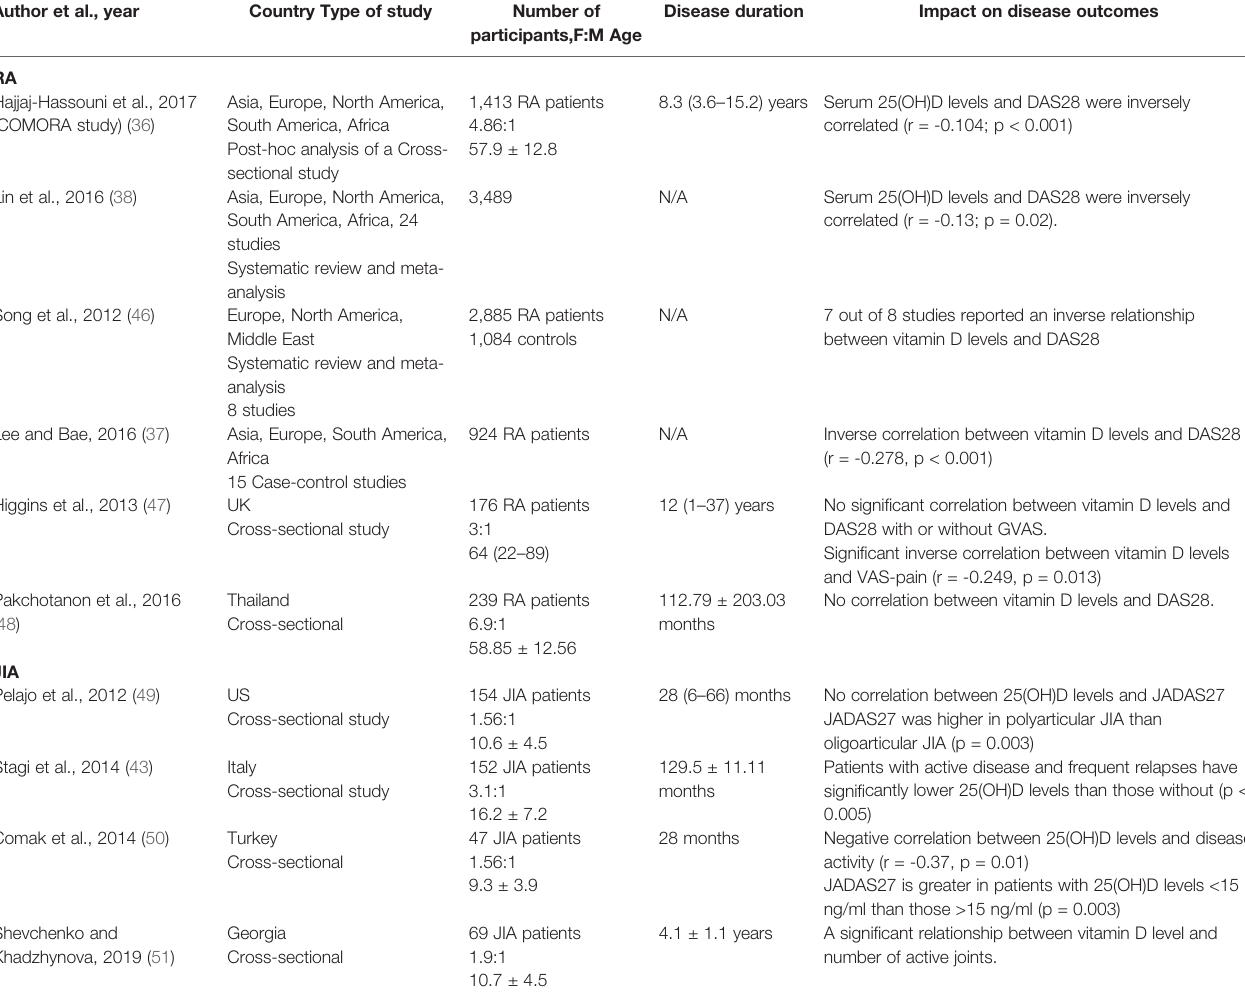
TABLE 2 | Impact of vitamin D concentration on RA and JIA